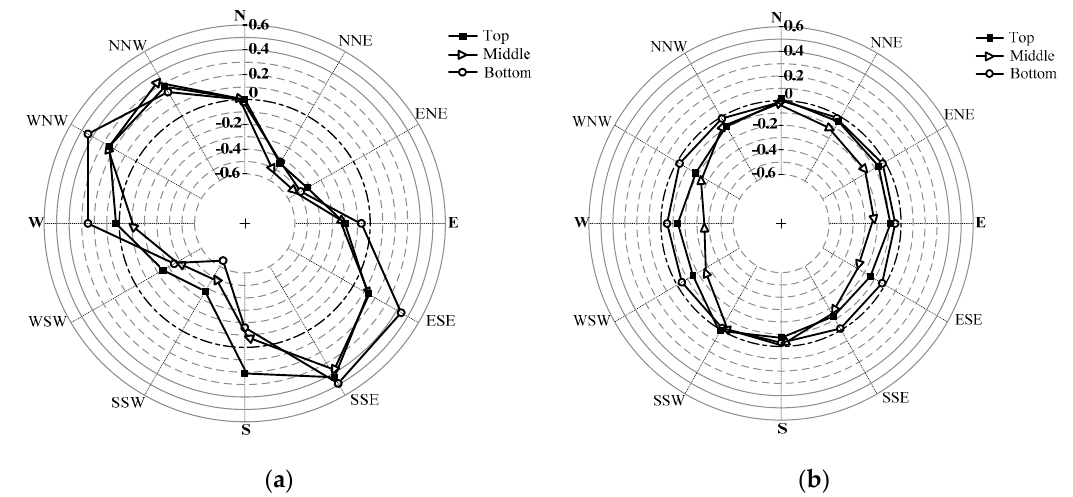
Figure 12. Distortions after ( a ) water cooling; ( b ) nitrogen cooling.